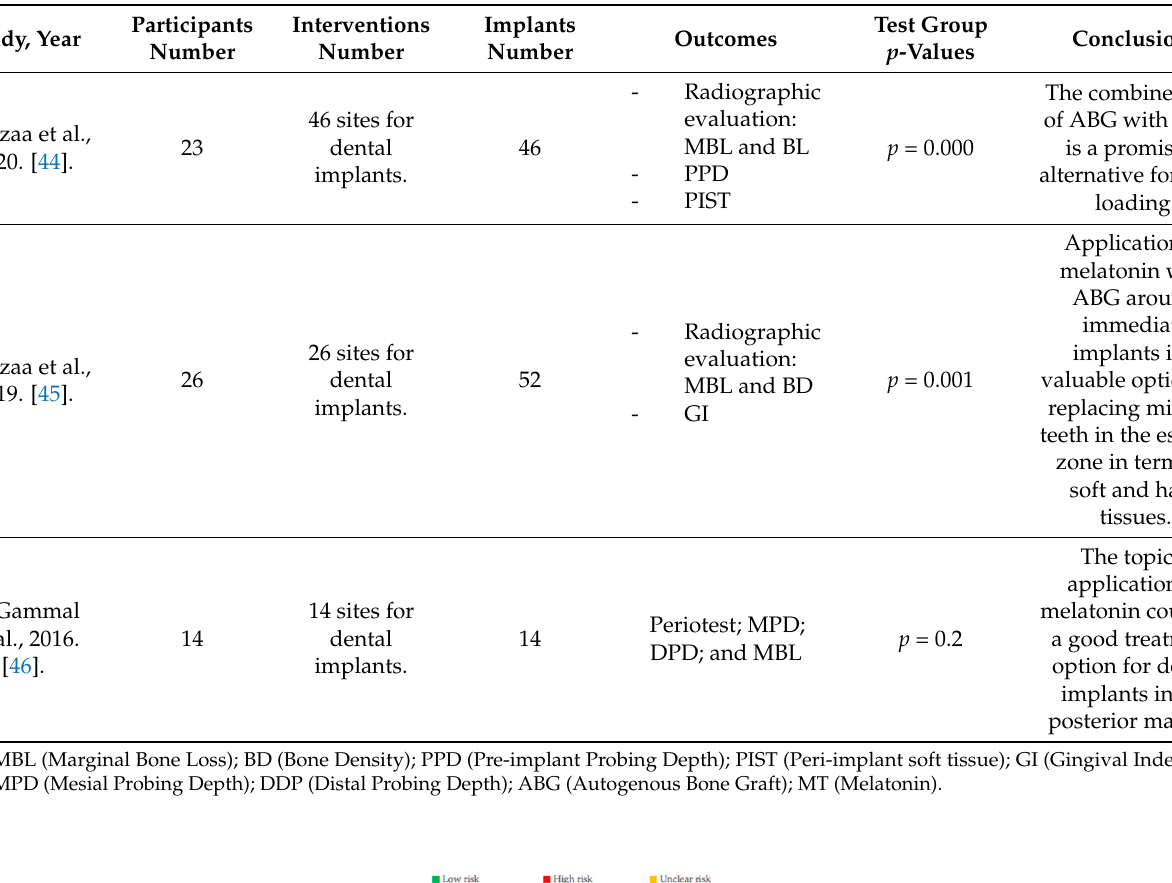
Table 4. Jadad quality score of randomized controlled trial, included in the meta-analysis.